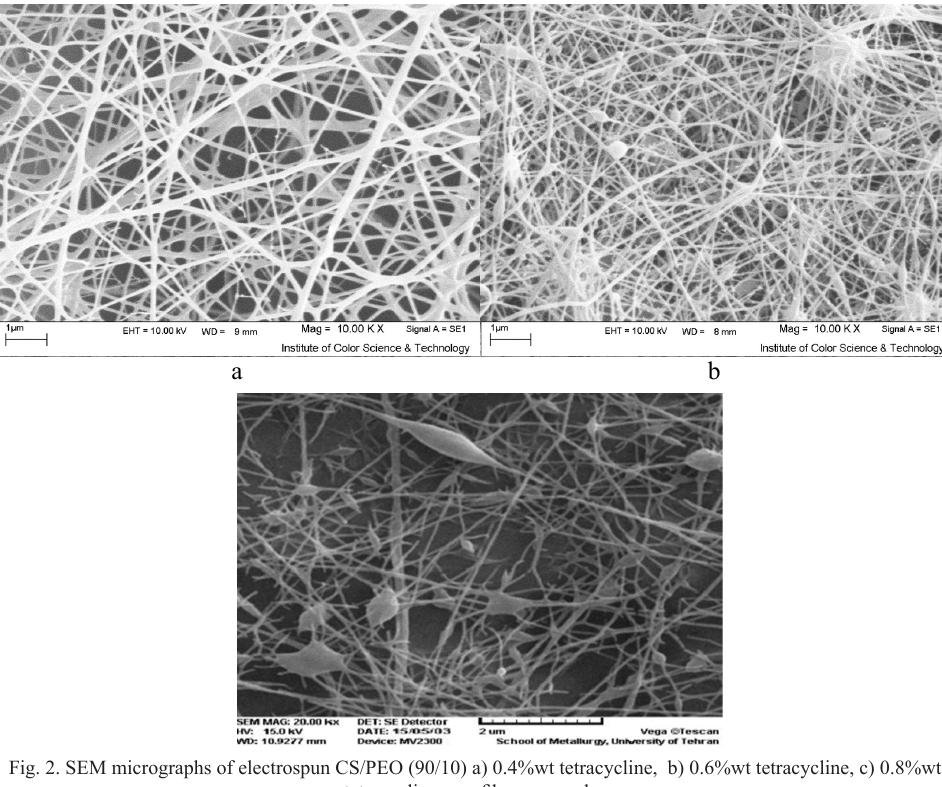
Fig. 2. SEM micrographs of electrospun CS/PEO (90/10) a) 0.4%wt tetracycline, b) 0.6%wt tetracycline, c) 0.8%wt tetracycline nanofibrous samples Fig. 2- SEM micrographs of electrospun CS/PEO (90/10) a) 0.4%wt tetracycline,